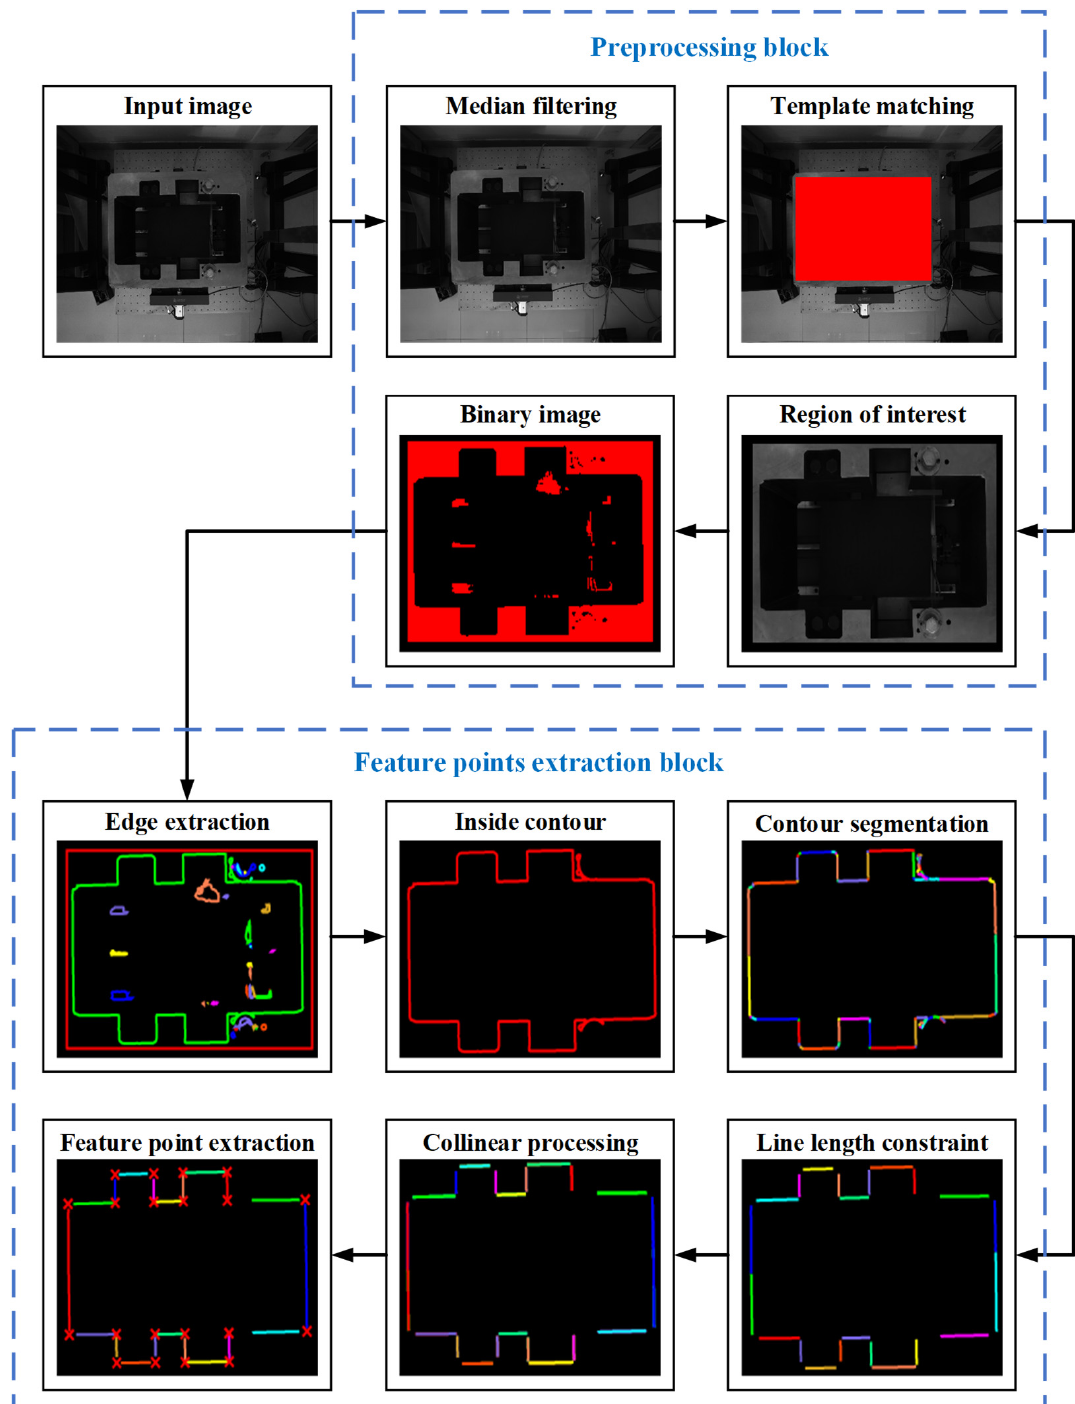
Figure 8. Image processing flow diagram.